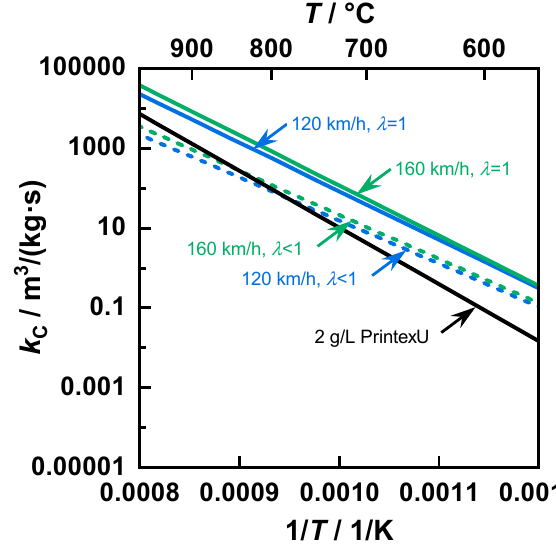
Figure 6. The reaction rate constant k c as a function of the inverse temperature for different soot types.